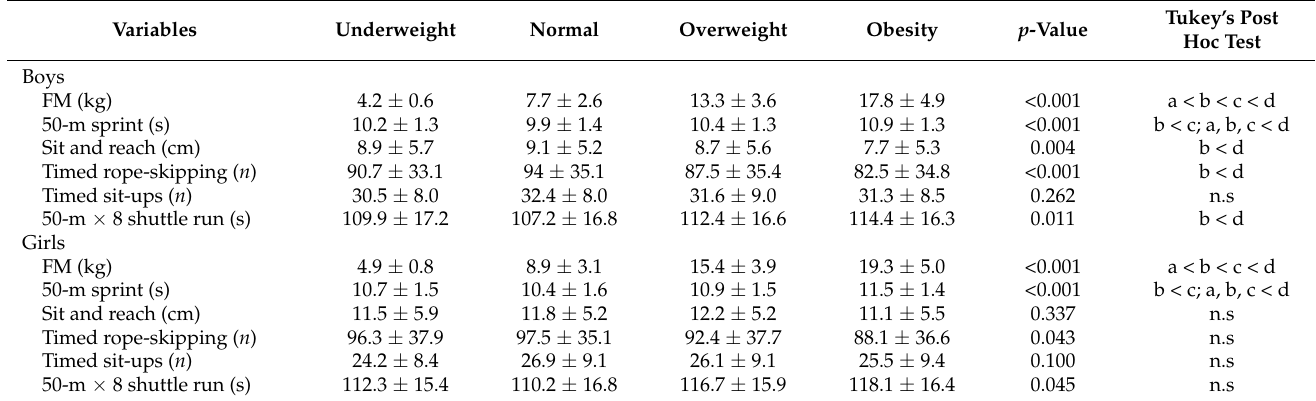
Table 2. Health-related physical fitness measurements according to BMI